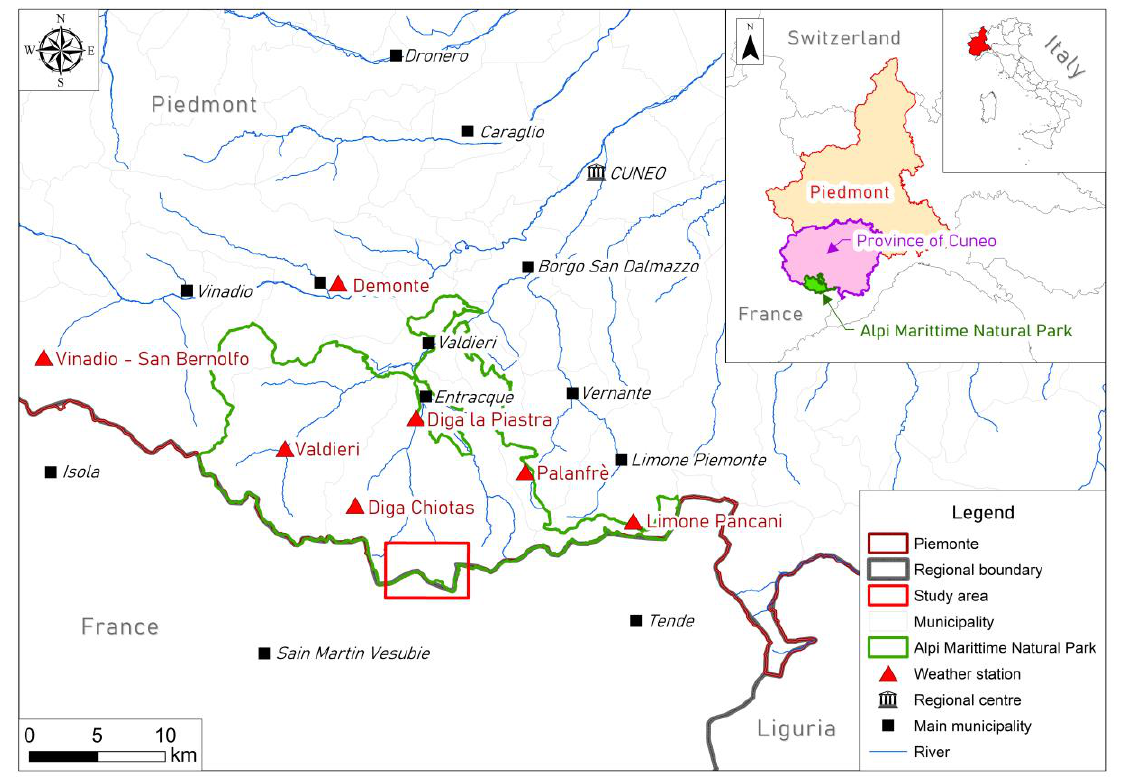
Figure 1. Location of the study area (red box) in the Natural Park of Alpi Marittime (Province of Cuneo, Italy). The seven weather stations considered for the analysis are represented with red triangles.